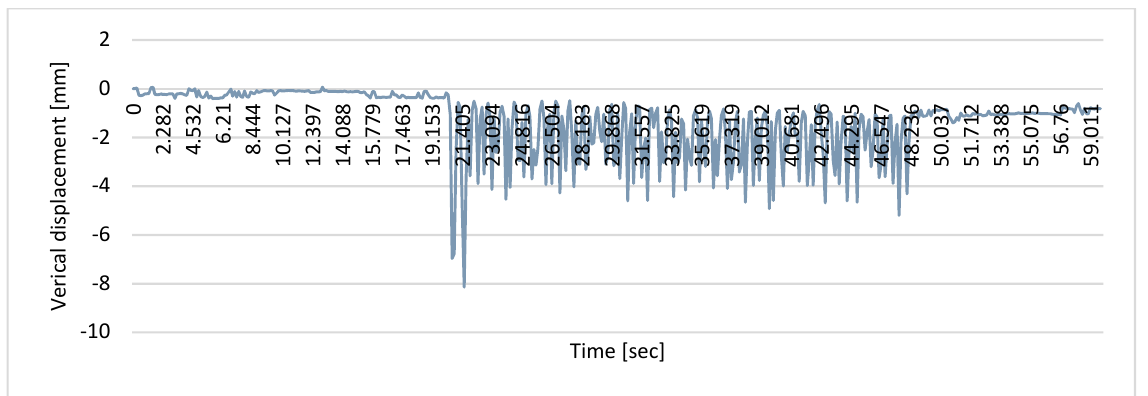
Figure 6. Results of a Leica TS 50 RTS vertical displacement measurement for a freight train in motion.